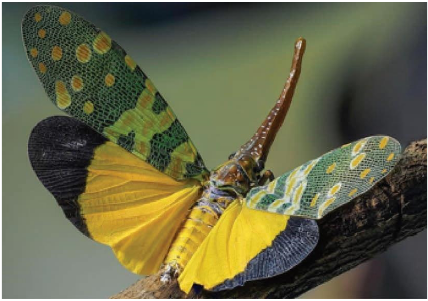
Figure 1: True images ( 243 × 349 × 3 ) .